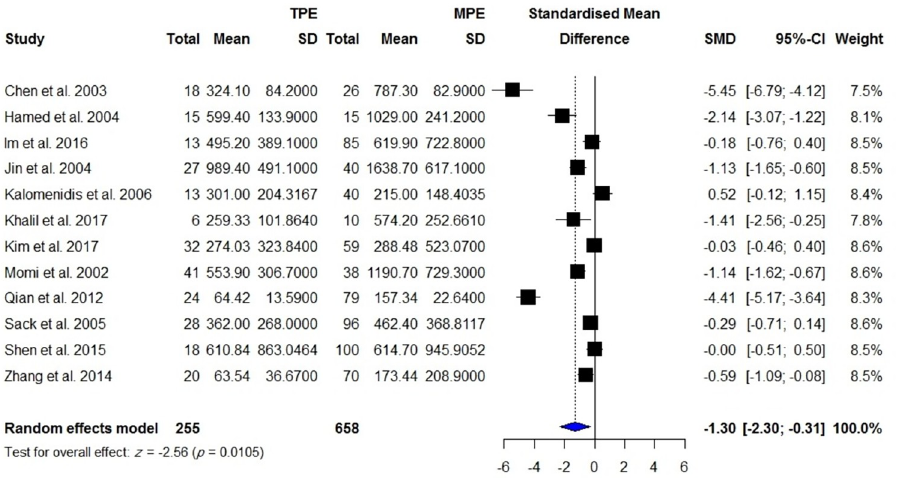
Fig 4. Meta-analysis of blood VEGF levels in patients with TPE vs. patients with MPE.